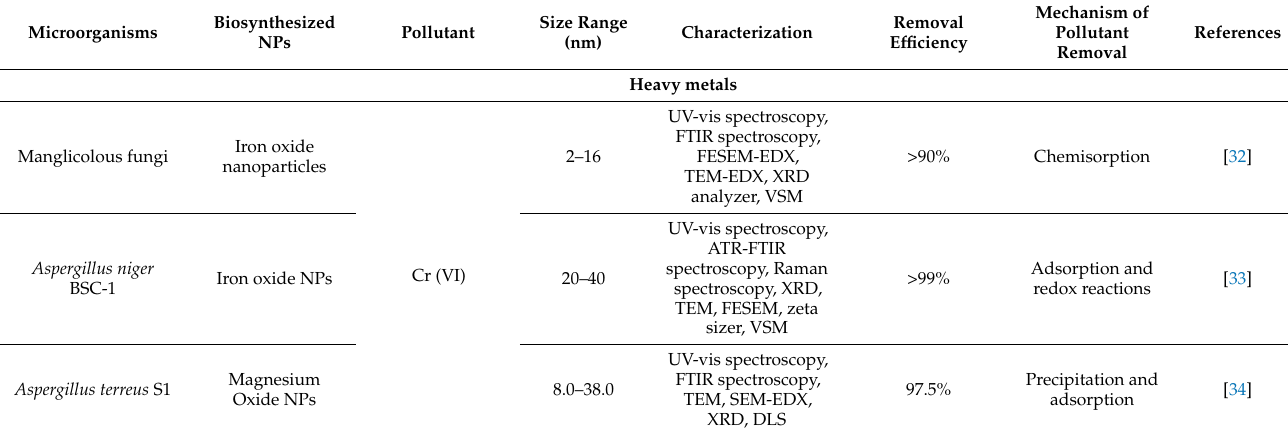
Table 1. Bio-nanoparticles for removal of wastewater